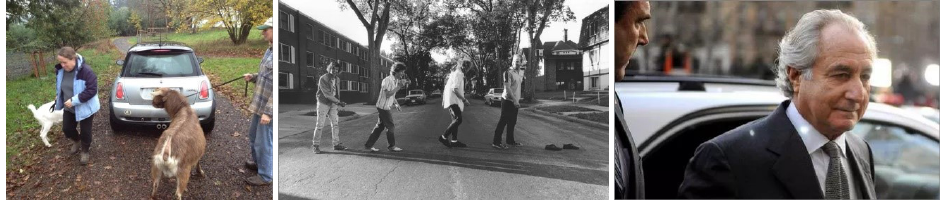
Figure 1. LSUN car dataset image noise examples